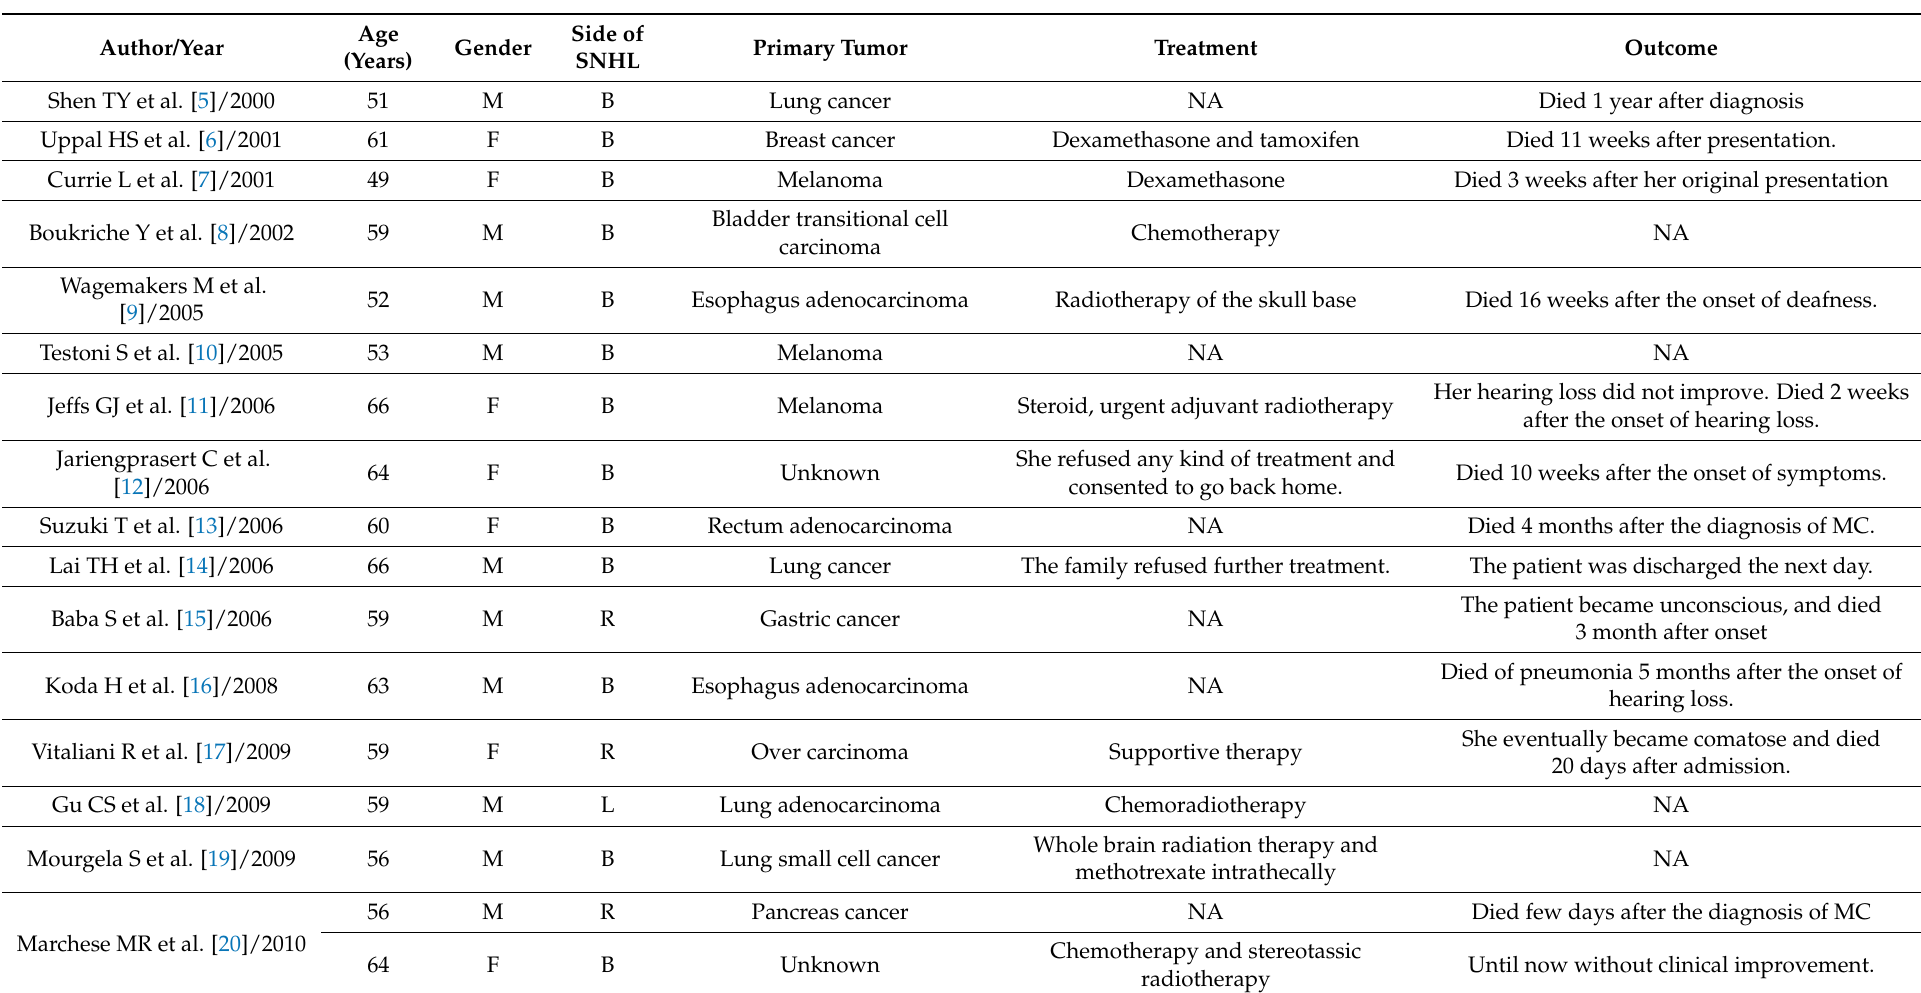
Table 3. The summary of the clinical data of 35 reported MC patients from publications and the present 8 cases with